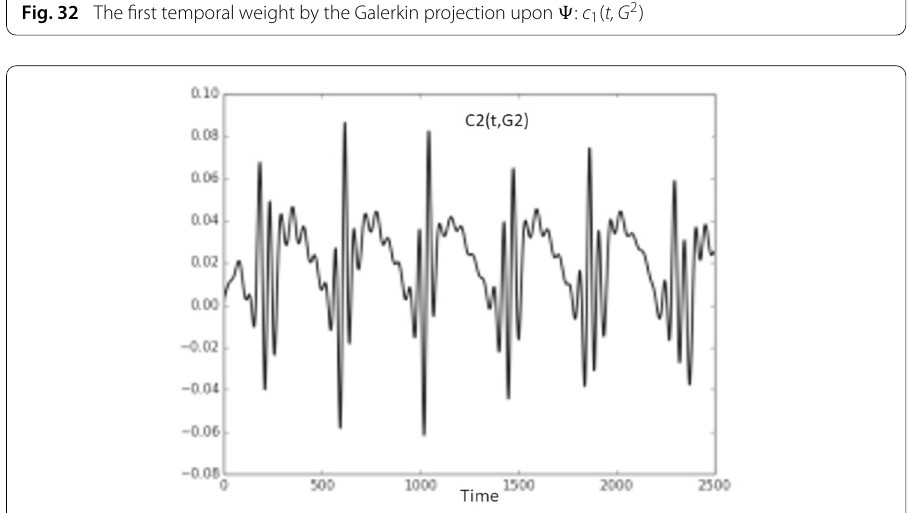
Fig. 33 The second temporal weight by the Galerkin projection upon (cid:9) : c 2 ( t,G 2 )